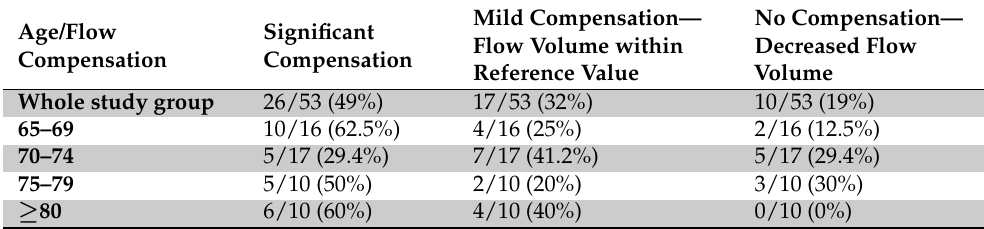
Table 3. Detailed data concerning the flow compensation in different age